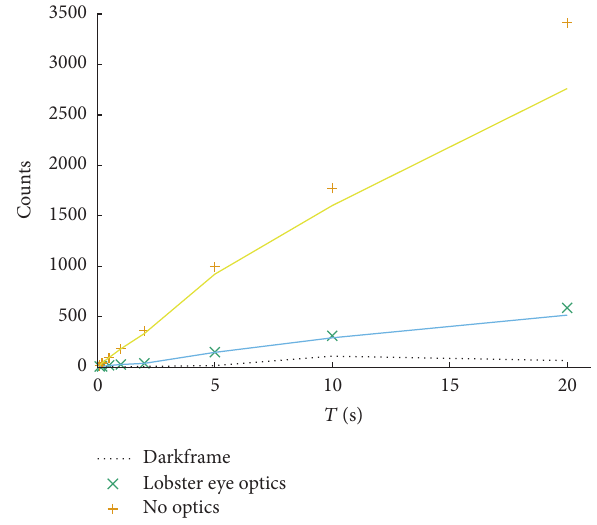
Figure 4: Laboratory count-rates @ 4.5 keV Titanium X-ray emis- sion for clear data (no optics), Lobster eye data, and closed shutter (darkframe with cosmic background). Crosses represent raw data and solid lines results after mathematical 8-neighbour one photon event filtration.